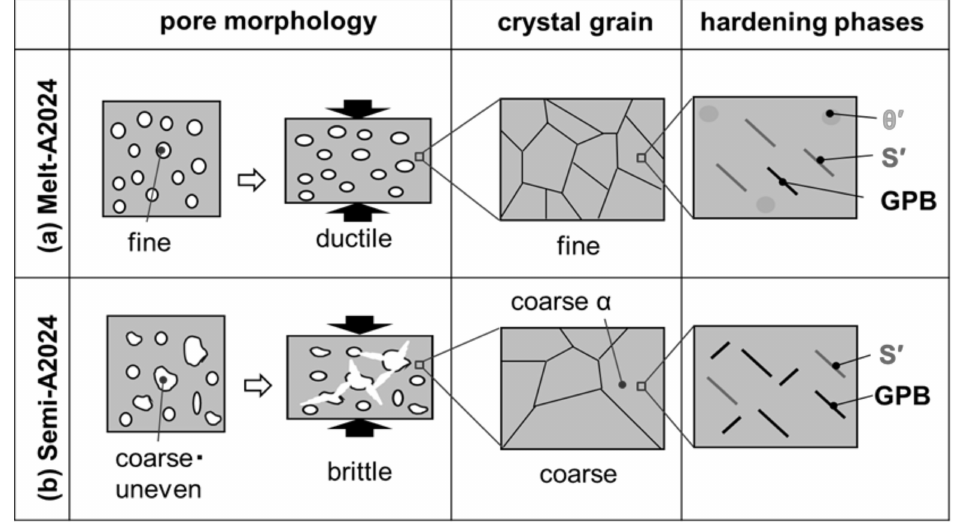
Figure 17. Schematic drawing of trend pore morphology and cell wall structure: ( a ) Melt-A2024; ( b )